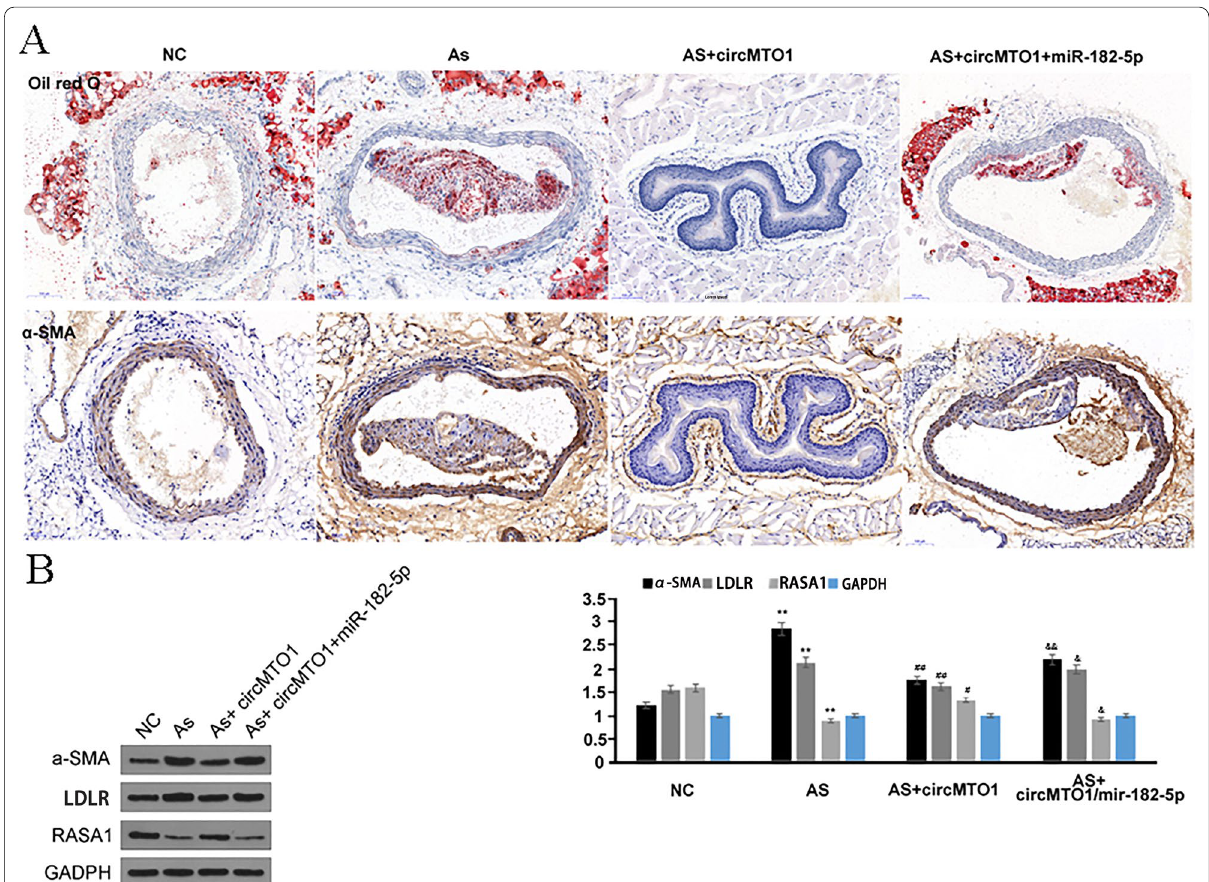
Fig. 6 CircMTO1 overexpression attenuated arteriosclerosis by sponging miR-182-5p in vivo. A Representative microscopic images of the aortic root of a 36-week-old ApoE − / − mice injected by AAV-modified vector via tail vein (AAV-PCDNA, AAV-pcDNA-circMTO1 and AAV-pcDNA-circMTO1/ AAV-miR-182-5p). Lipid fixation was performed followed by oil red O (red) and smooth muscle α-actin (SMA, yellow) staining. B Western blot results of α-SMA, LDLR (LDL receptor), RASA1 and GADPH in the AS mice (AAV-PCDNA, AAV-pcDNA-circMTO1 and AAV-pcDNA-circMTO1/AAV-miR-182-5p). * vs NC group, # vs AS group, & vs AS circMTO1, **P < 0.01, *P < 0.05, ## P < 0.01, # P < 0.05, && P < 0.01, & P < +